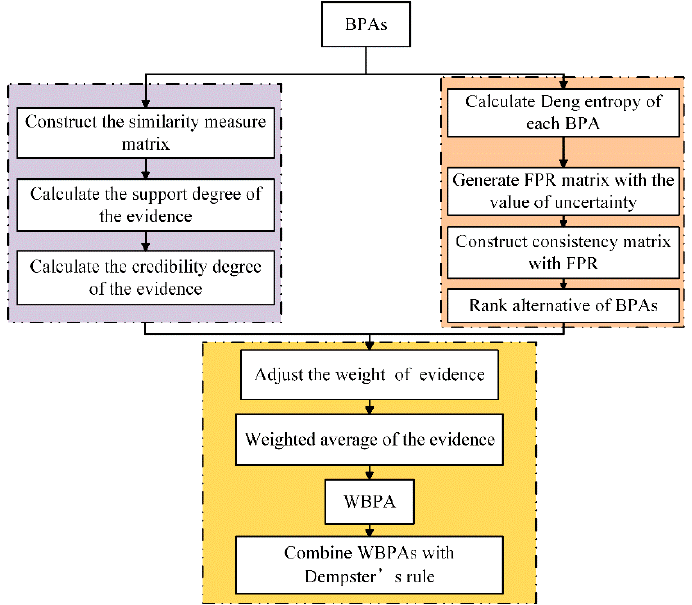
Figure 1. The flowchart of the proposed Dempster-Shafer theory (DST).